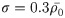
Different foraging environments with associated patch decision strategies.Shown are simulation results with the density-adaptive and robust-counting strategies in two different foraging environments. (A,D) illustrates the foraging environment for a given case, (B,E) shows average energy and patch residence time when a particular strategy is used in that environment along with the MVT-optimal energy energy (E*) and patch residence time (T*), and (C,F) shows simulation results compared to MVT-optimal strategies in each environment. All simulations use a noise level of σ=0.3ρ0¯ and a patch size of A = 5, and the robust counting strategy is implemented by setting α = −0.2ρ0. (A-C) Uncertainty in patch food density. Patches have a Gaussian distribution for initial food density with mean of ρ0¯=9.439 and a standard deviation of Δρ0=0.3ρ0¯, and rewards are received continuously (c = 0). Travel time between patches is constant at Ttr = 5. The solid line in (C) shows an approximate analytical solution (Methods, Eq 25) for small changes in ρ0 about ρ0¯. (D-F) Scattered patches with discrete rewards. Food reward is received in discrete chunks (c = 8) and each patch has the same initial food density of ρ0 = 9.439. Travel time between patches is drawn from an exponential distribution with mean Ttr¯=5. (F) shows a histogram of simulation results for how many food chunks were taken before leaving the patch, for both the density adaptive strategy (left) and the robust counting strategy (right).